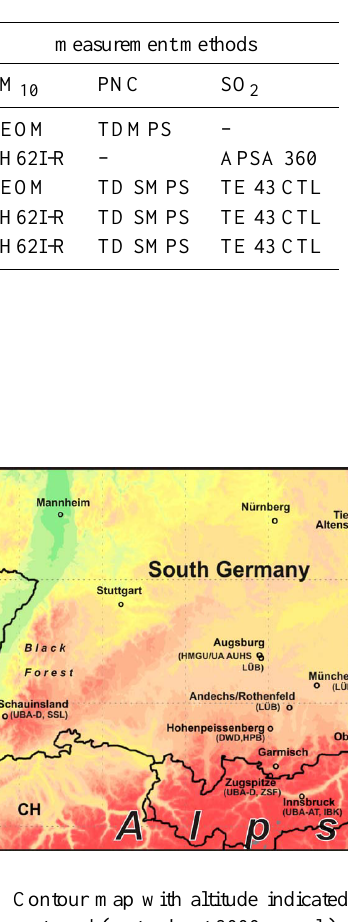
Fig. 1. Contour map with altitude indicated by different colours from green to red (up to about 3000ma.s.l.) showing the positions of the Bavarian Air Monitoring Network (L ¨UB) sampling sites where daily PM 10 samples were investigated (see Sect. 3.3 also and later in the text where the acronyms are used): Andechs/Rothenfeld (ADRO), Augsburg (B¨urgermeister-Ulrich-Strasse) (AUB ¨U), M¨unchen (Landshuter Allee) (M ¨ULA), Oberaudorf (Inn val- ley motorway) (OBIA), Tiefenbach/Altenschneeberg (TBAL). Further sites include (see Table 1 also) Schauinsland (German Umweltbundesamt (UBA-D), SSL), Zugspitze/Schneefernerhaus (German Umweltbundesamt (UBA-D), ZSF), Hohenpeissenberg (Deutscher Wetterdienst (DWD), HPB), Innsbruck (Austrian Umweltbundesamt (UBA-AT), IBK) and Augsburg (Helmholtz Zentrum M¨unchen/University of Augsburg (HMGU/UA),